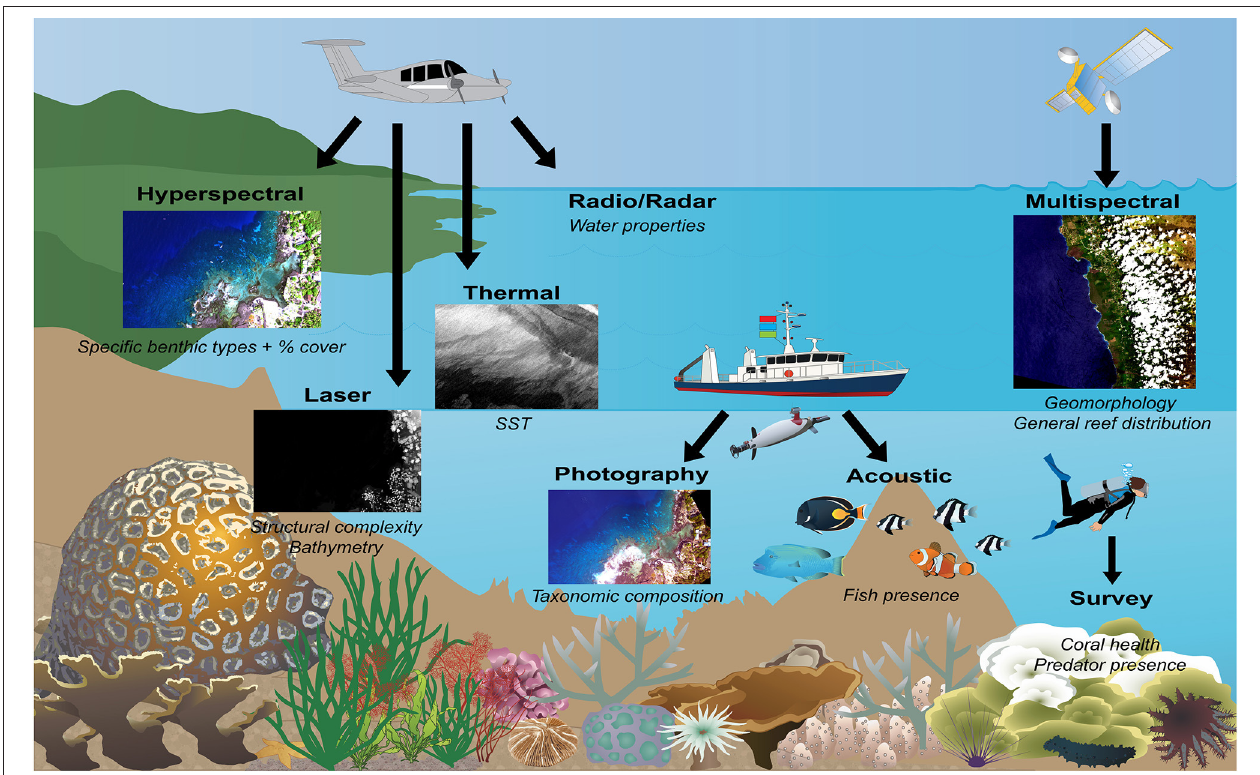
FIGURE 1 | Remotely sensed measurements that can inform coral reef restoration activities. Key criteria considered by restoration practitioners are paired with the current platform and sensing technology that is most mature and developed, for the criterion at the required resolution to inform fragment collection, coral outplanting, and monitoring efforts. Remote sensing technology examples are provided by the Carnegie Airborne Observatory ( Asner et al., 2012) where possible, for the same section of reef at representative resolutions. Symbols are courtesy of the Integration and Application Network, University of Maryland Center for Environmental Science